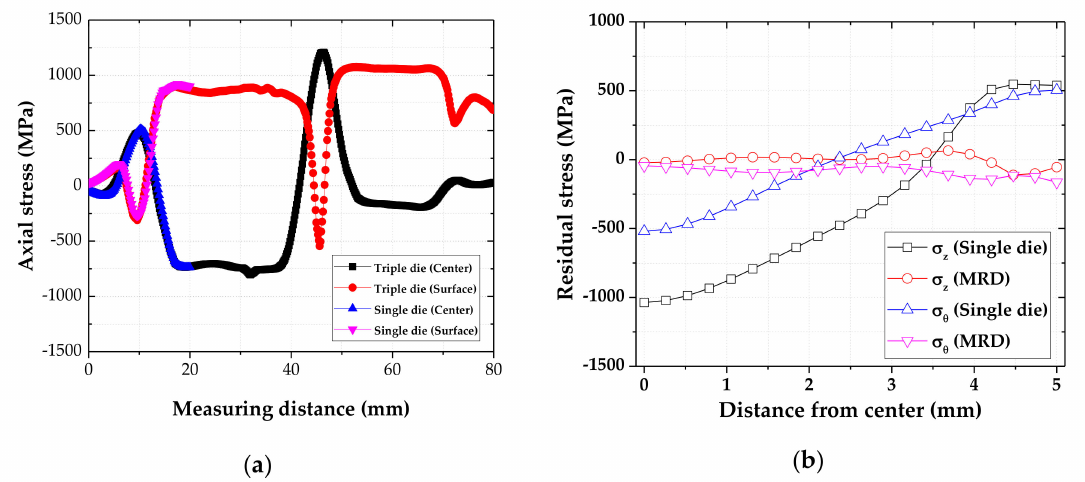
Figure 13. Comparison of stresses of the material drawn using the optimal MRD and the single die: ( a ) axial stress during the drawing process; ( b ) residual stress of drawn materials.